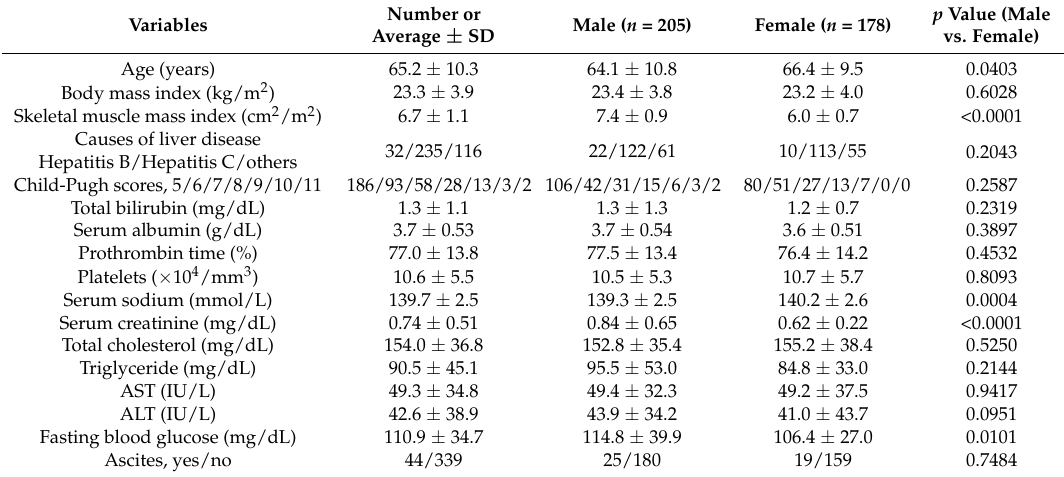
Table 1. Baseline characteristics ( n = 383).